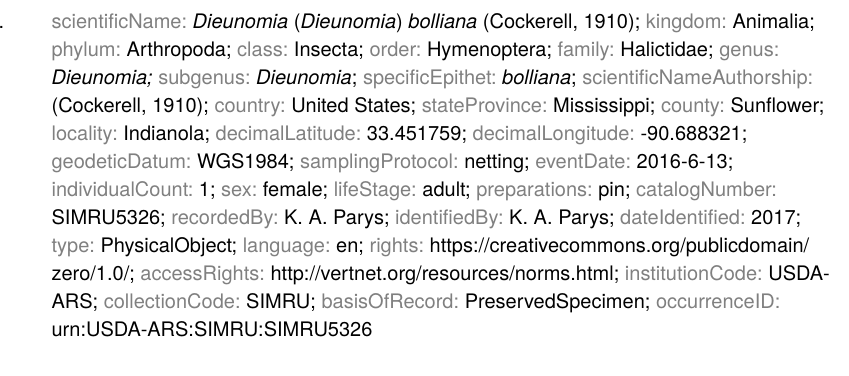
Family Halictidae Dieunomia ( Dieunomia ) bolliana (Cockerell, 1910) Materials a.